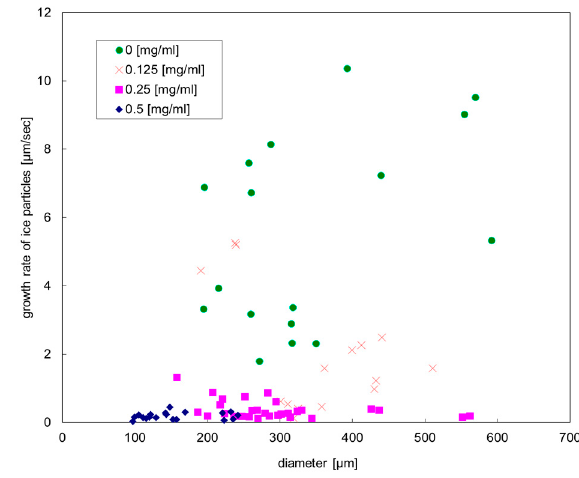
Figure 4. Relationship between the diameters of ice particles and the growth rates of the ice particles.